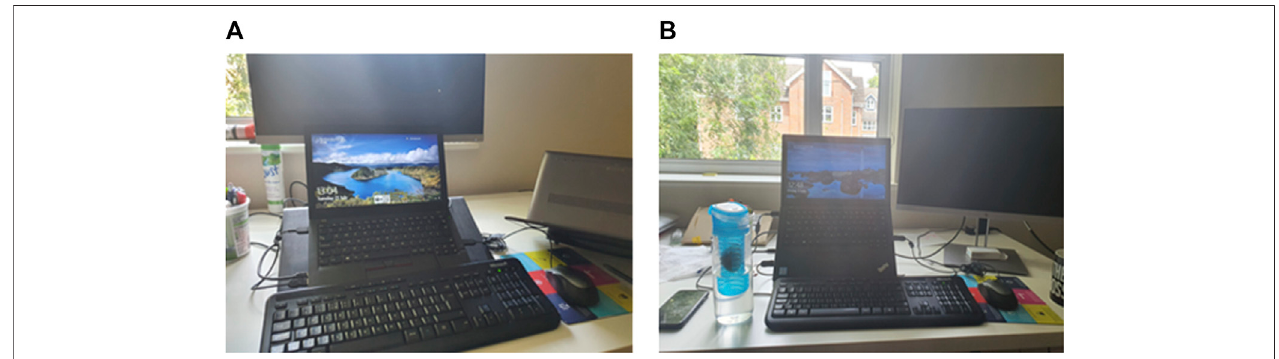
FIGURE 5 | Comfort and ambient